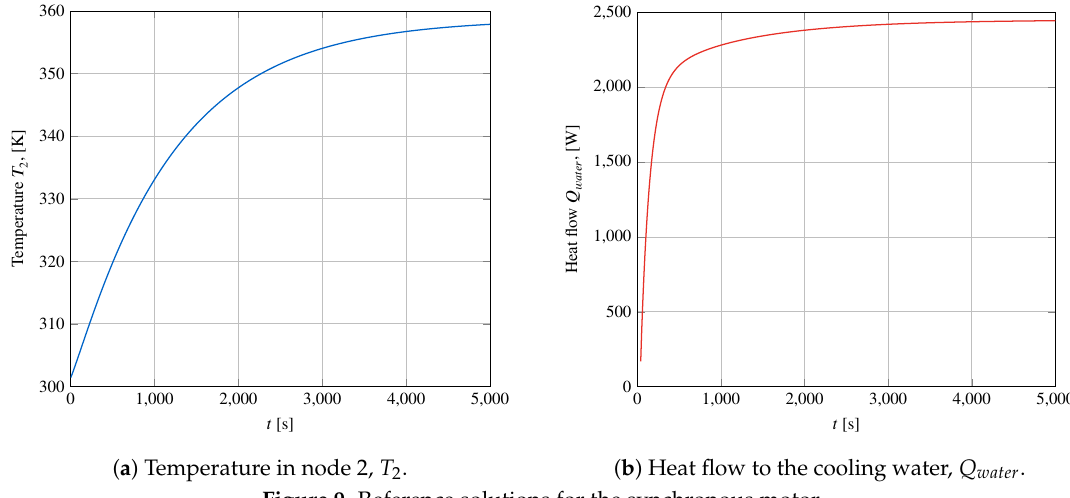
Figure 9. Reference solutions for the synchronous